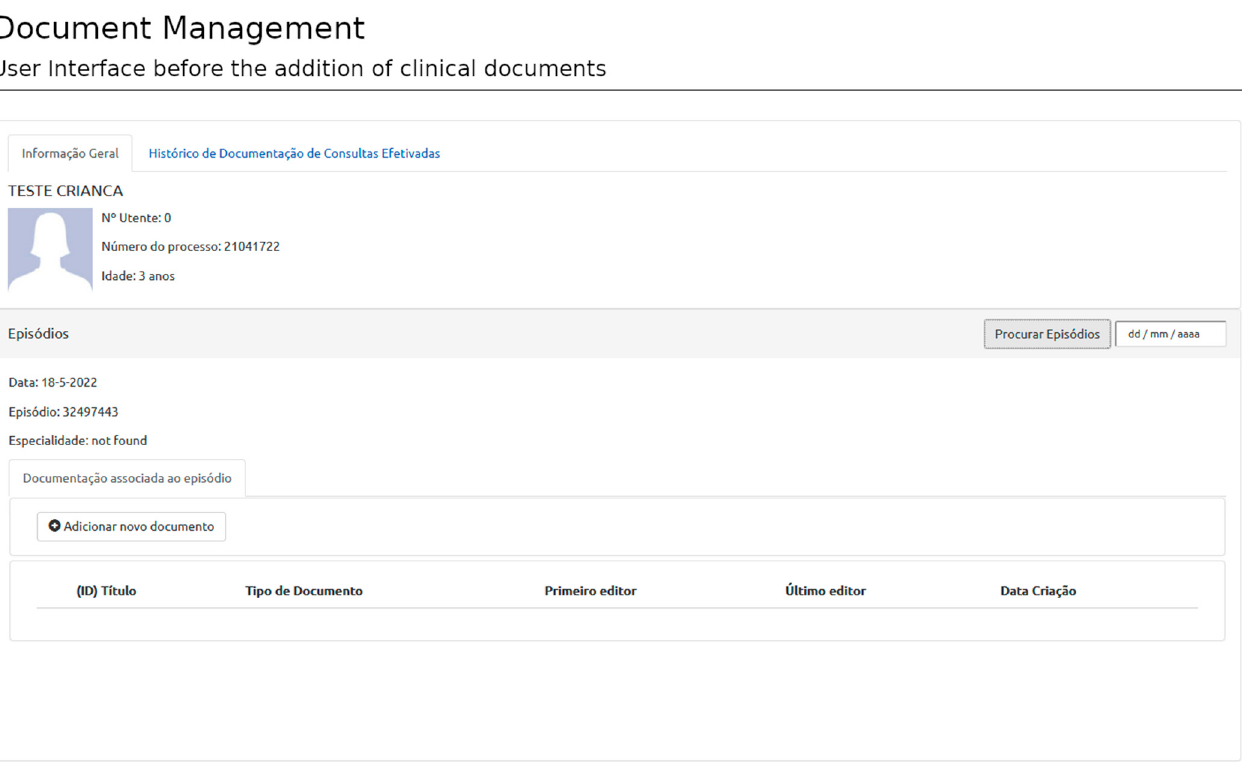
Figure 6. Document creation: User interface after authentication. The user is presented with the essential patient and episode information and can add clinical documents related to that medical encounter. This image describes a fake patient created for display purposes. (The Portuguese terms have the following translations in English: Informação Geral: General Information; Histórico de